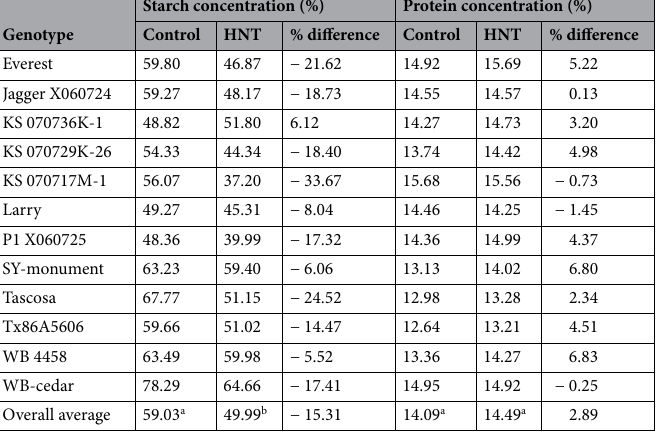
Table 3. Starch and protein concentration (%) of mature seeds in 12 field-grown winter wheat genotypes exposed to HNT and control environments during grain filling. Means were separated using Tukey’s honest significant difference (HSD) test at p = 0.05 and statistically significant differences (p < 0.05) between the overall average of control and HNT are indicated by superscripts.